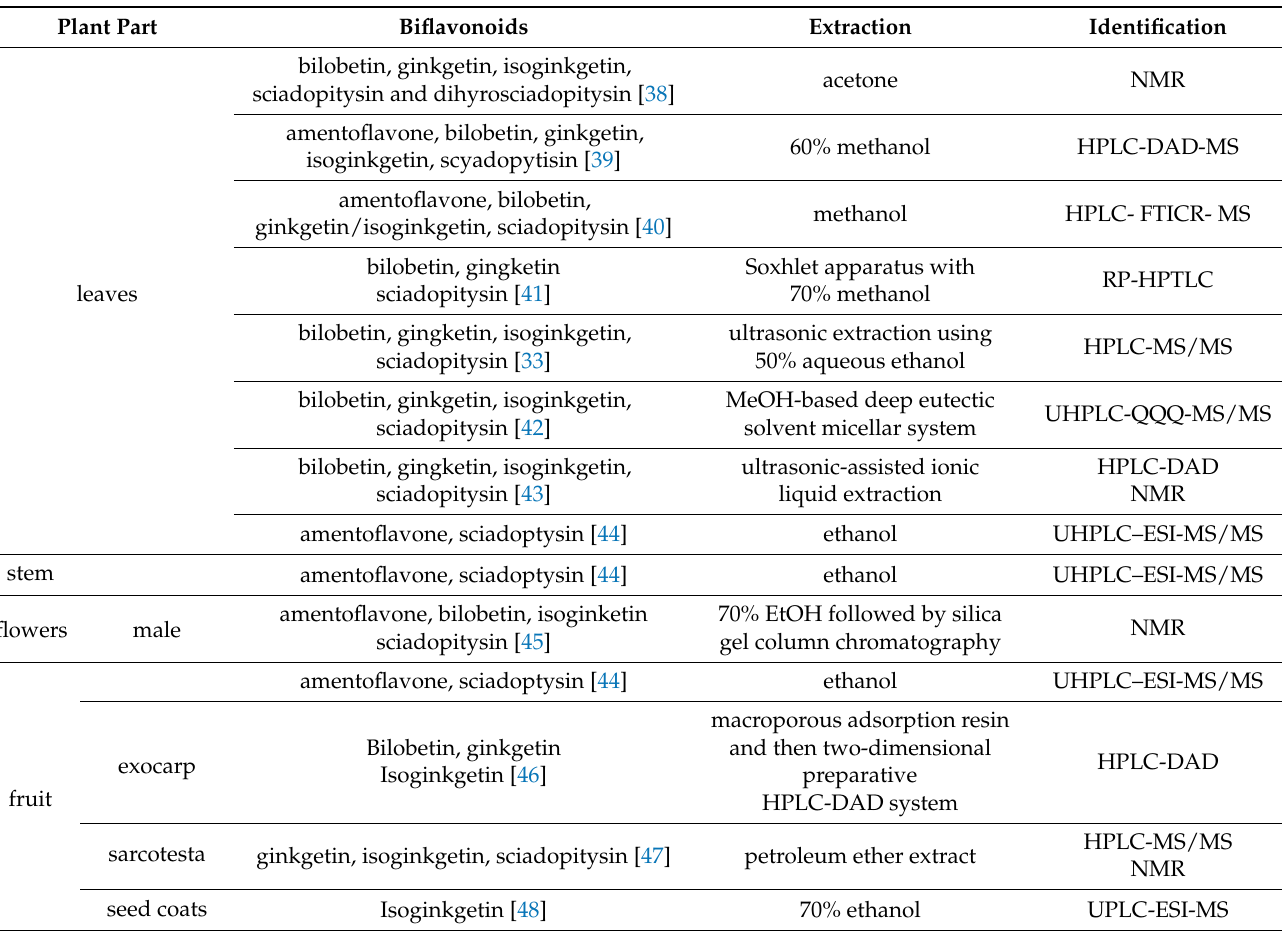
Table 3. Example of extraction and identification methods used for analysis of ginkgo biflavonoids from different plant